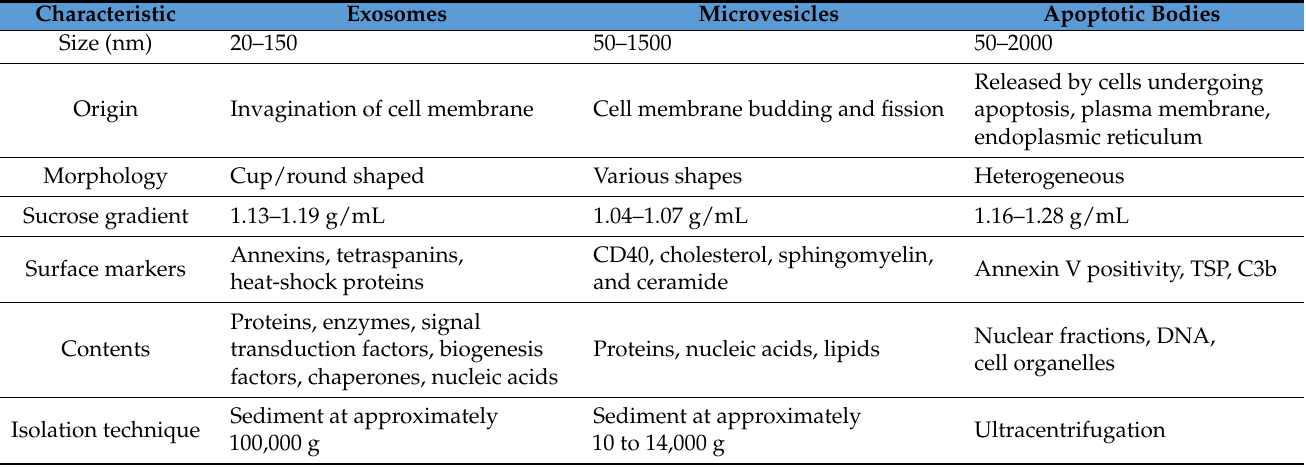
Table 1. The characteristics of